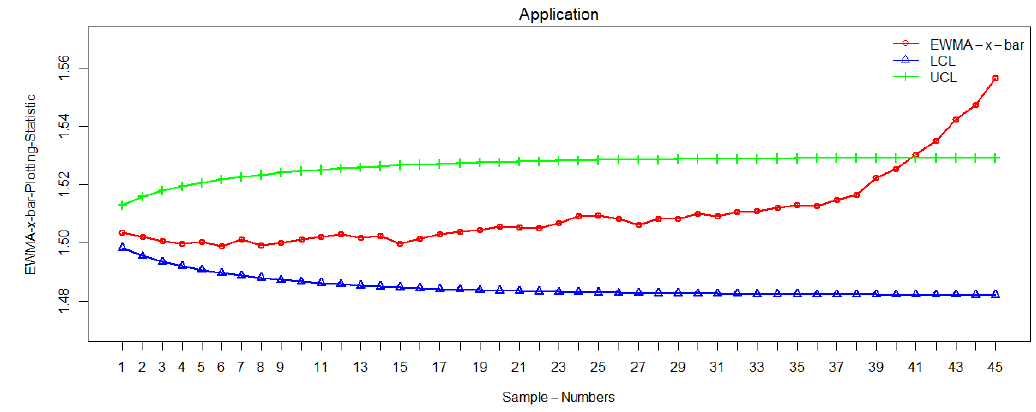
Figure 9. Real-life application of the EWMA- 𝑋̅ control chart in a hard-bake manufacturing process.